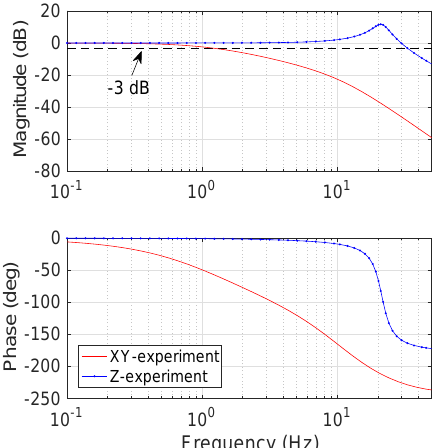
Figure 8. Bode diagram of the proposed alternating electromagnetic field generation system from system